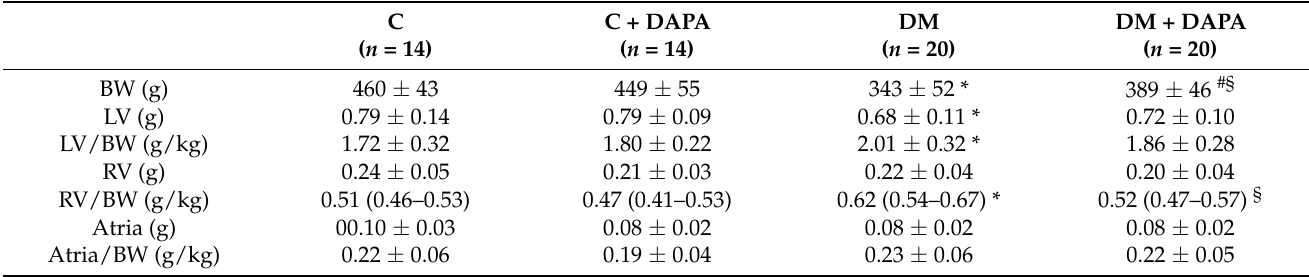
Table 5. Anatomical data.